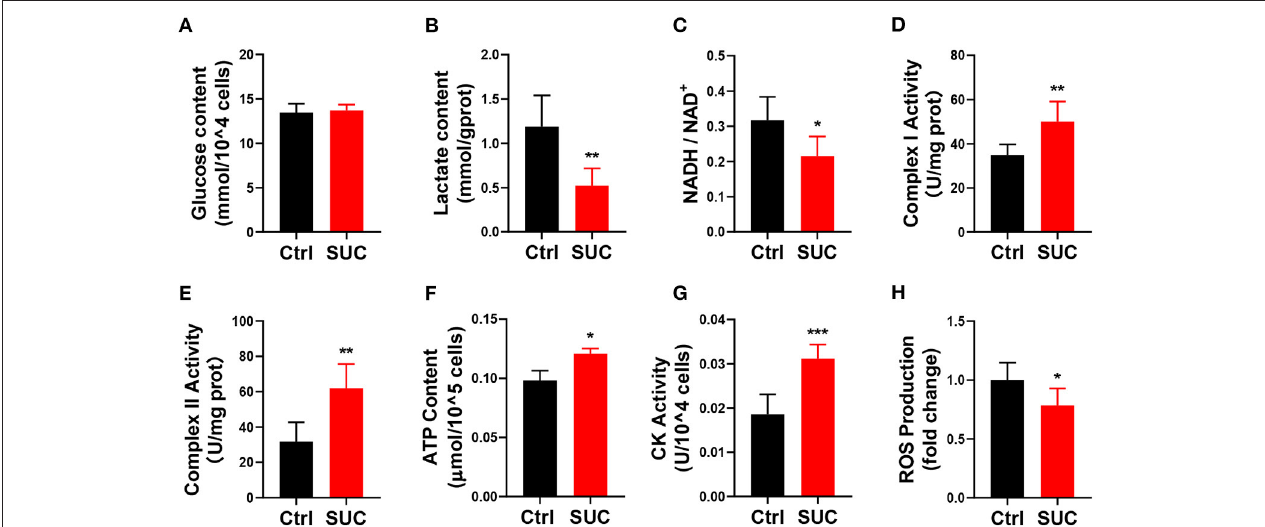
FIGURE 2 | SUC promotes oxidative phosphorylation in C2C12 cells. C2C12 cells could be observed in mature fibers after induced differentiation for 4–6 days, and then cells were treated with 1mM SUC for 1h to detect oxidative phosphorylation. (A) Glucose content in cells. (B) Lactate content. (C) NADH/NAD + ratio change. (D) Complex I activity. (E) Complex II activity. (F) ATP content. (G) CK activity. (H) ROS fold change compared to the control group. n = 6 for each group. Each value is shown as the mean ± SEM. *, **, and *** indicate P < 0.05, 0.01, and 0.001,